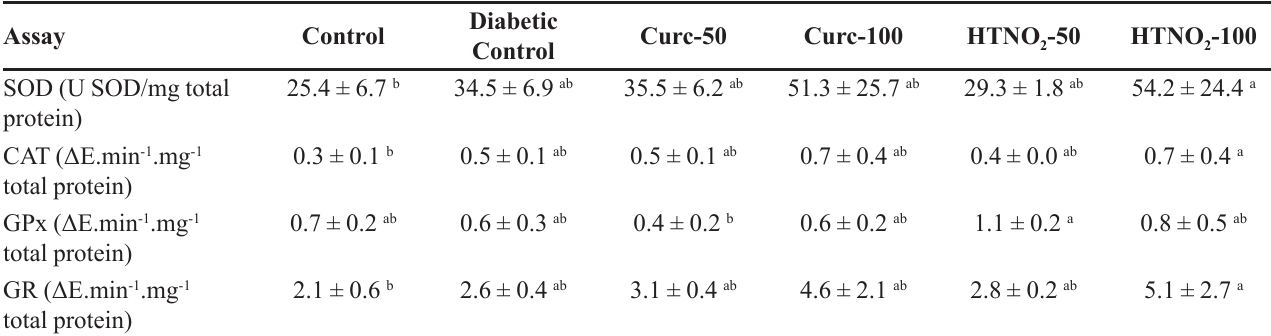
TABLE V - Evaluation of liver enzymes activity – SOD, CAT, GPx, GR